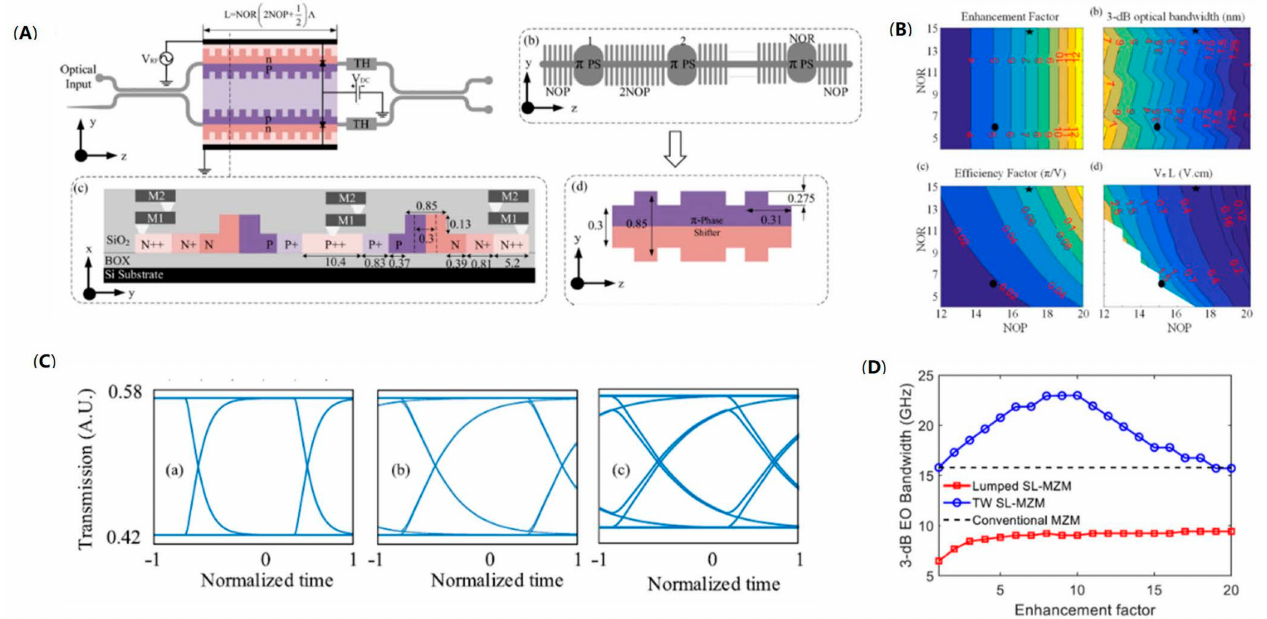
Figure 14. The model of silicon Bragg grating modulator. ( A ) Schematic of the silicon Bragg gratings modulator [70]. ( B ) Enhancement factor γ , optical bandwidth, efficiency factor, and modulation efficiency with the change of NOP and NOR [70]. ( C ) Eye diagram simulated at 30 Gb/s, 70 Gb/s, and 110 Gb/s [70]. ( D ) EO bandwidth as a function of enhancement factor for silicon Bragg gratings modulator with different electrodes